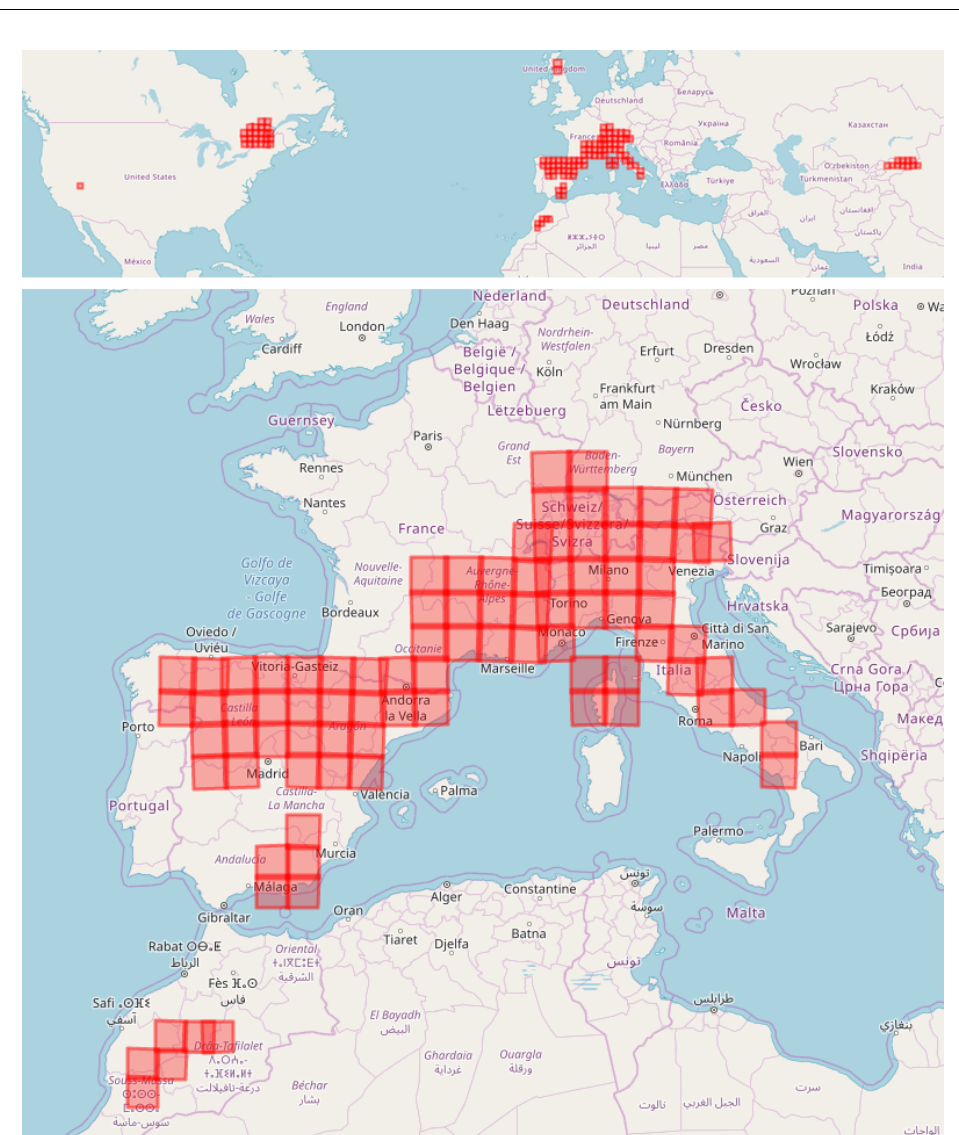
Figure 4. Coverage of the Theia Snow collection